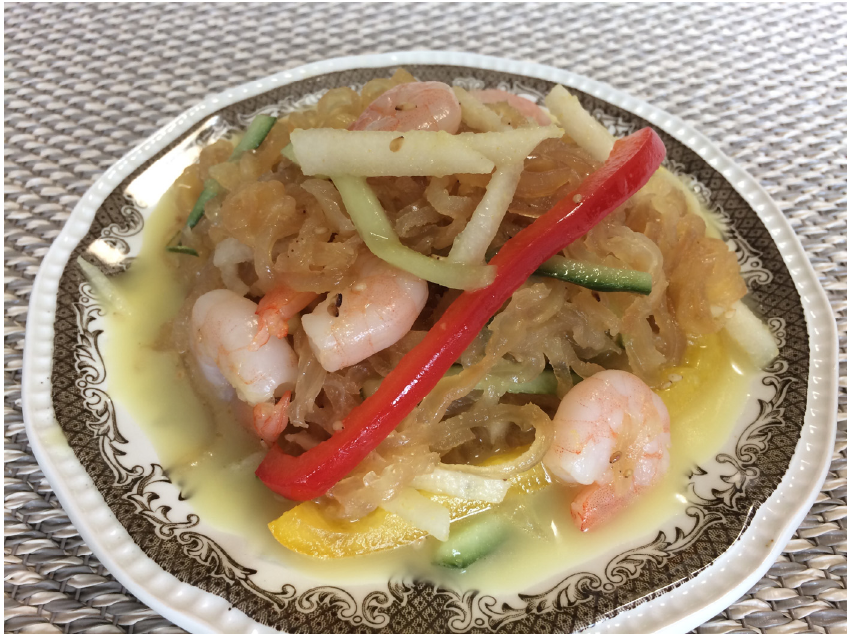
Figure A2. Ingredients: jellyfish, cucumber and condiments: vinegar, sesame oil, salt, sugar, soy sauce, garlic; see recipe at: http://kimchimari.com/cold-lemon-jellyfish-salad/.